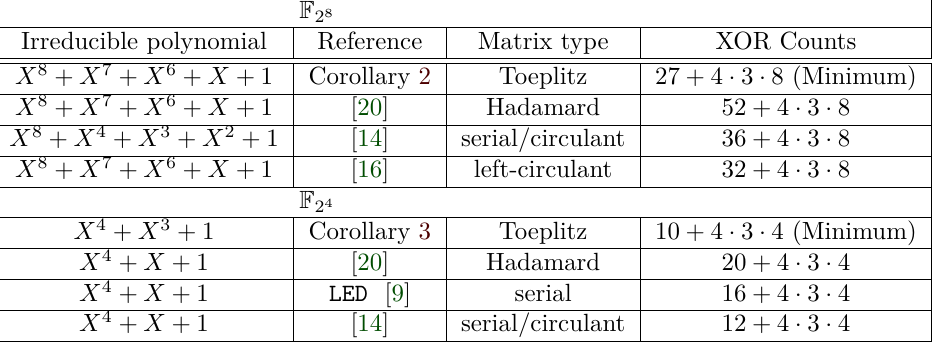
Table 1: Comparison of the minimum XOR count of 4 × 4 MDS matrices over F F with the previous known 2 4